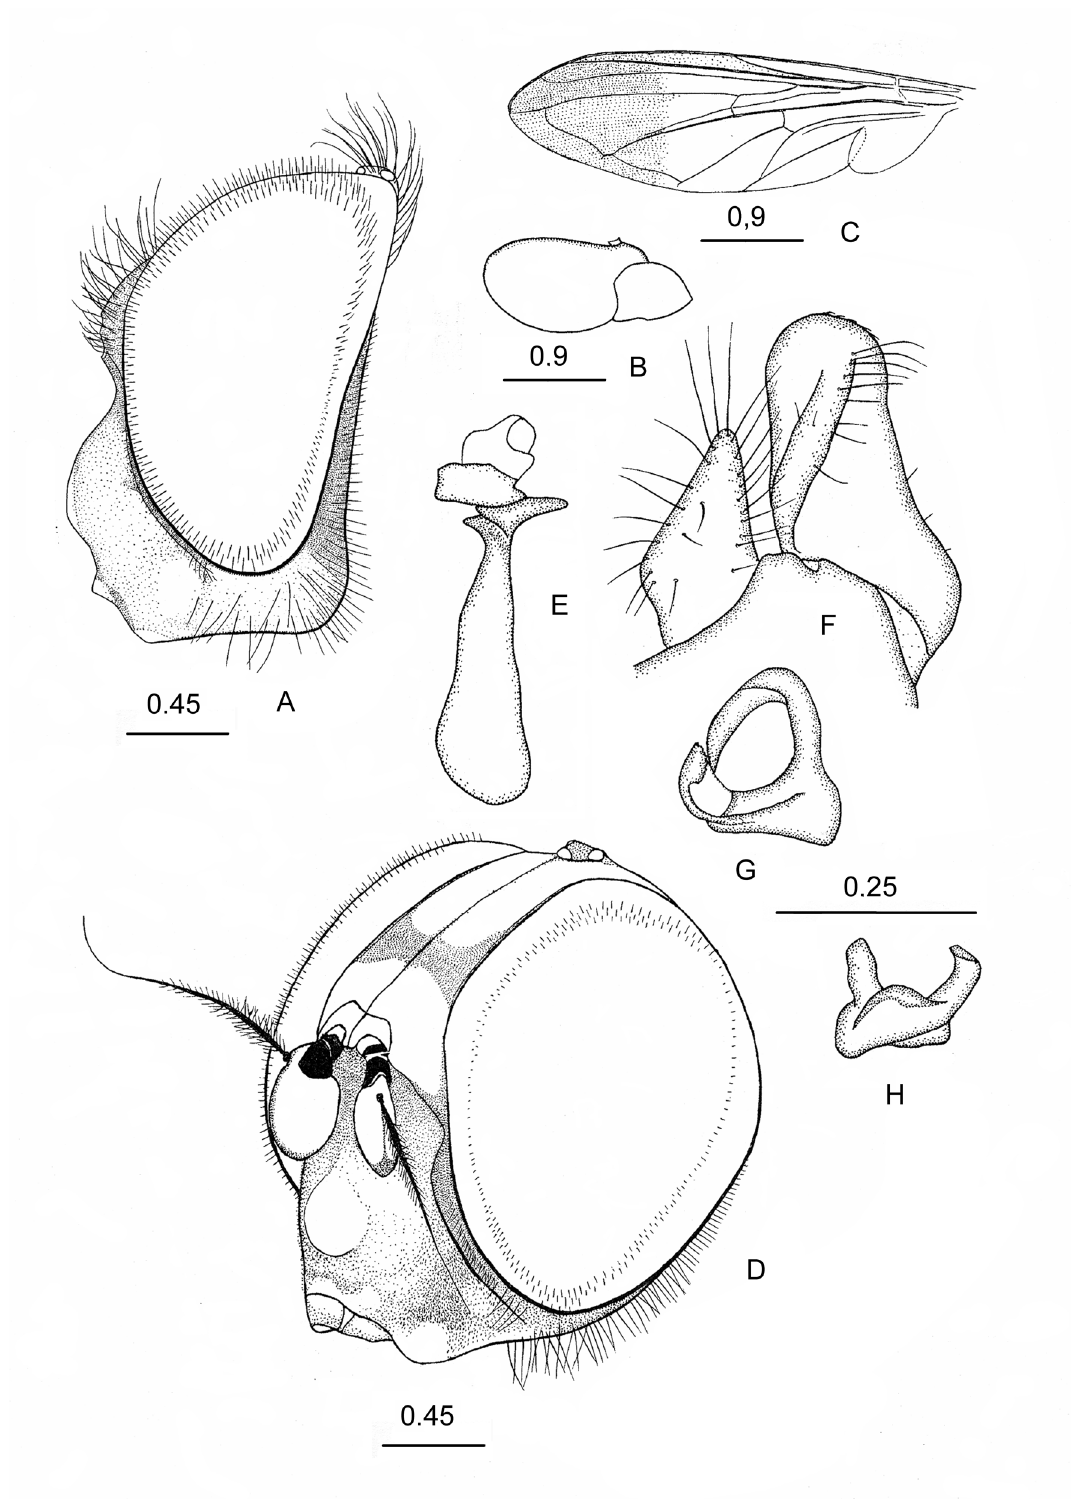
Fig. 37. Cheilosia lucida Barkalov & Cheng, 1998. A . Head of ♂, lateral view. B . Antenna of ♂, lateral view of pedicel and basoflagellomere. C . Wing. D . Head of ♀, anterior view. E . Aedeagus and aedeagal apodeme, lateral view. F . Surstylus and gonocercus, lateral view. G–H . Superior lobes of hypandrium, lateral view. After Barkalov & Cheng 2004. Scale bars indicated in